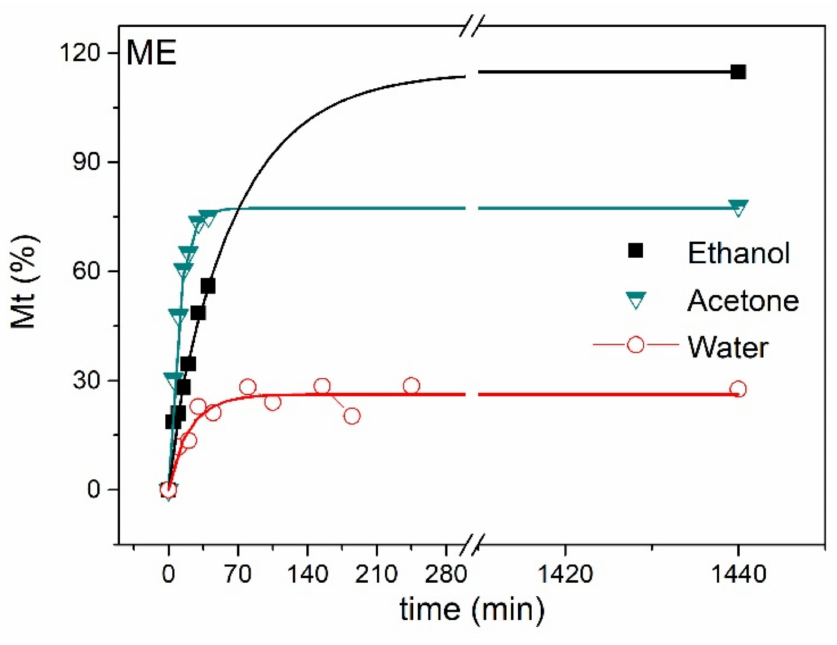
Figure 9. ME swelling curves in water, acetone and